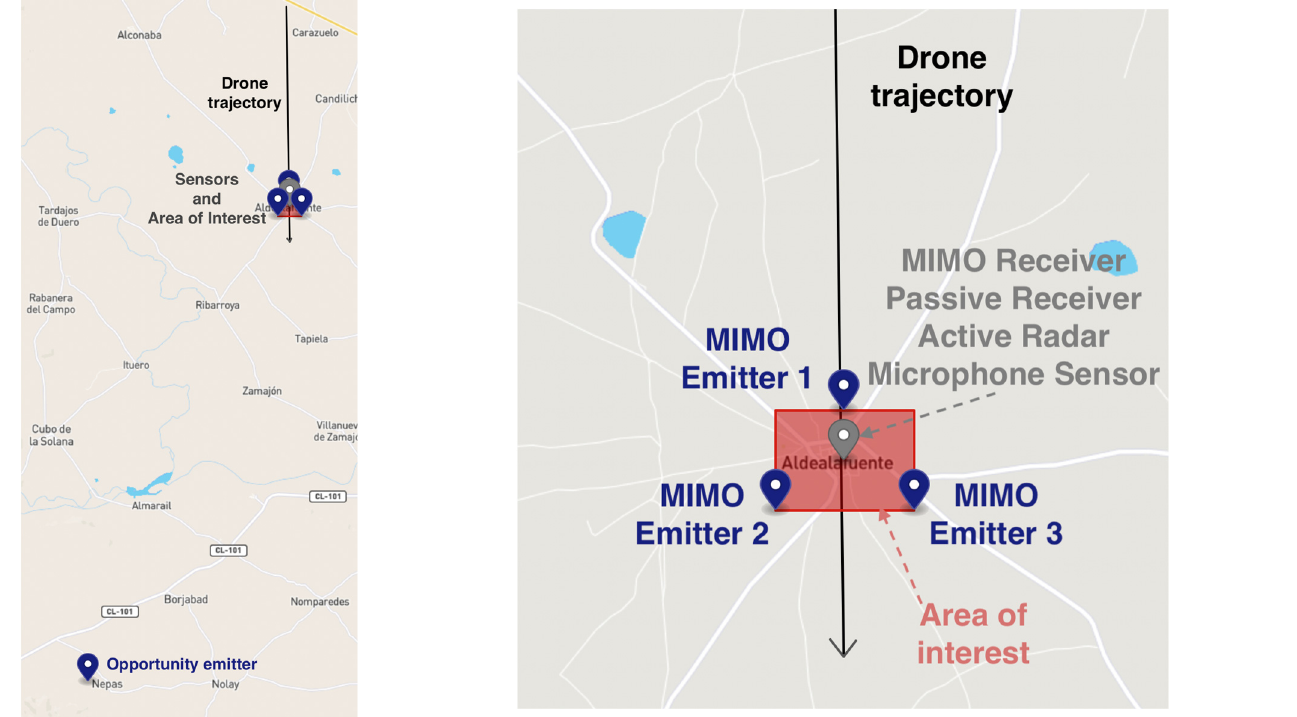
Figure 3. Graphical representation of the proposed scenario.